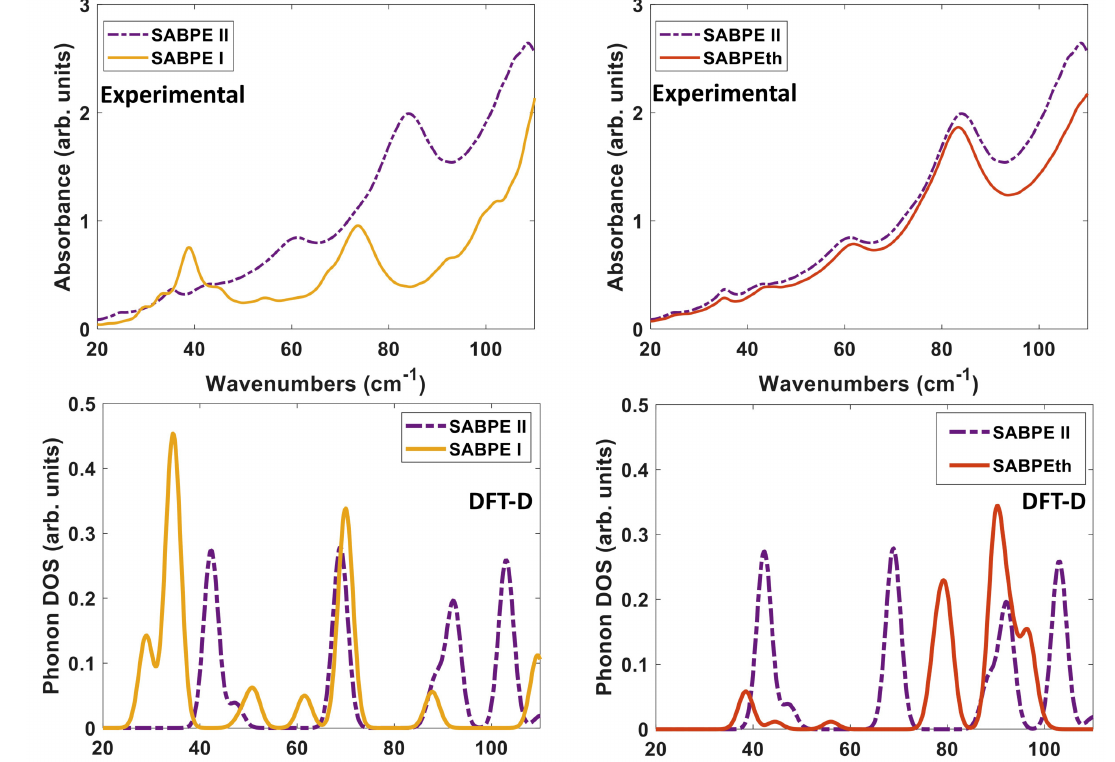
Figure 10. Comparisons of the Experimental THz spectra ( top ) and DFT-D computed phonon modes ( bottom ) of ( left ) 2(SA) · BPE-I (solid yellow line) and 2(SA) · BPE-II (dash-dotted purple line), and ( right ) 2(SA) · BPE-II (dash-dotted purple line) and 2(SA) · BPEth (solid orange line). For 2(SA) · BPE-II and 2(SA) · BPEth, the DFT-D calculated IR active modes are consistently